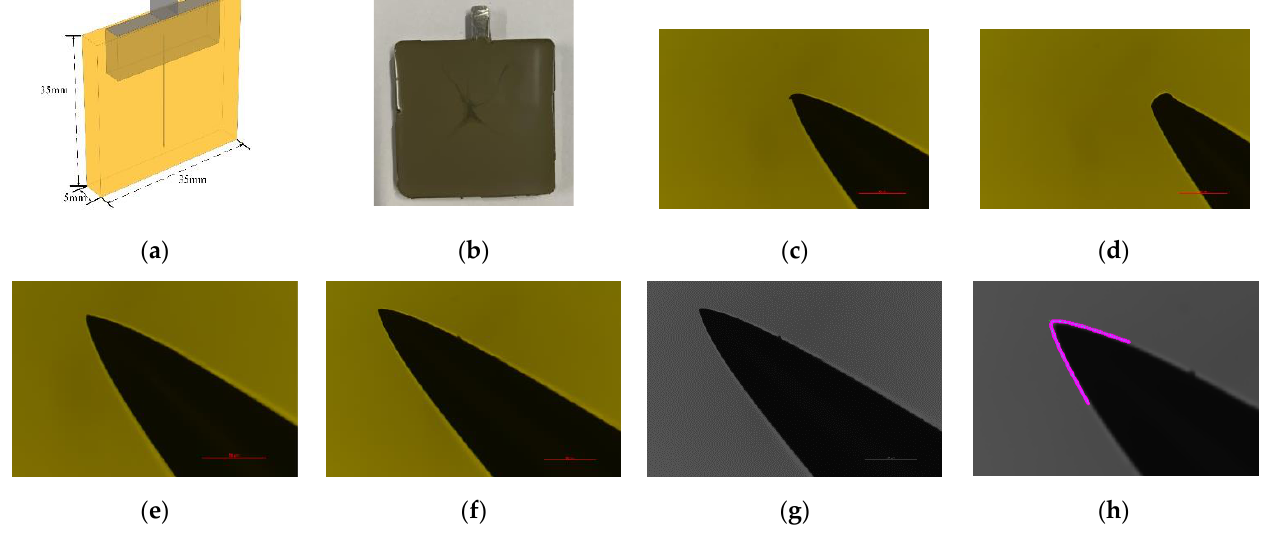
Figure 3. ( a ) Schematic diagram of sample size and electrod arrangement for PD testing; ( b ) Sche- matic diagram of PD sample; ( c ) Microscope picture of distorted needle tip; ( d ) Microscope picture of blunt needle tip; ( e ) Needle electrode with symmetrical shape and rounded tip; ( f ) Original image of needle tip; ( g ) Grayscale image in 8-bit of needle tip; ( h ) The contour of needle tip.